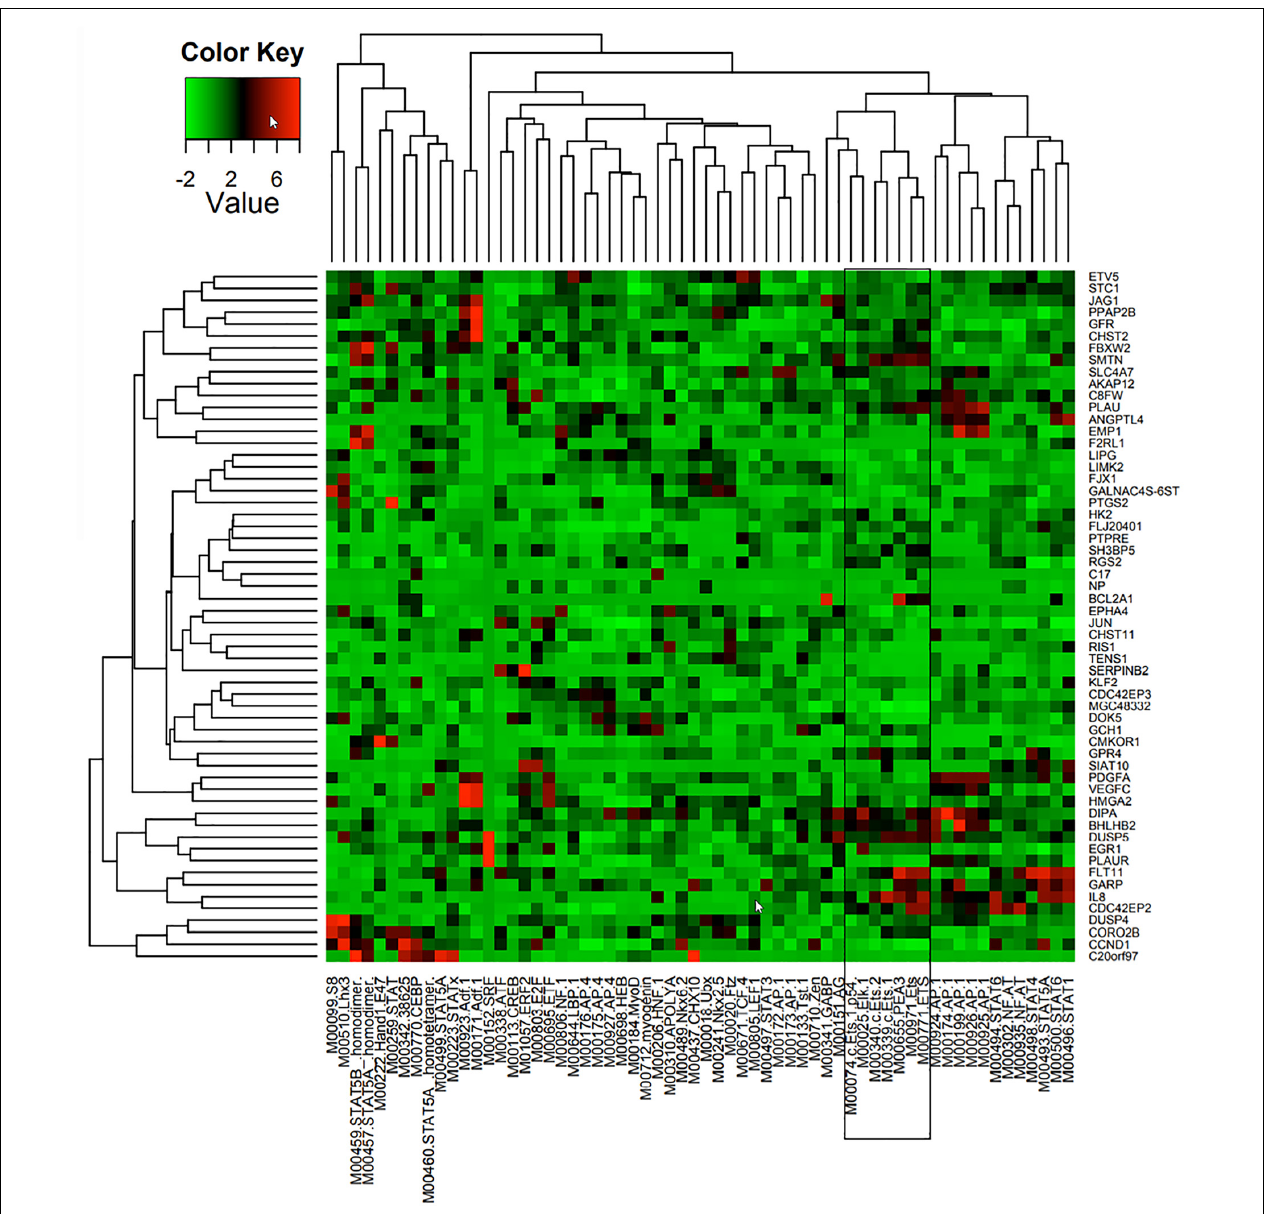
FIGURE 1 | Predicted TF regulators of Ang-1-induced genes in ECs. Heat map representing 58 genes ( Y axis) that were upregulated in HUVECs in response to 4 h of Ang-1 exposure. Genes are clustered according to Z-scores obtained from 62 position weight matrices generated using TRANSFAC and JASPAR databases and based on flanking regions 10 kb upstream or downstream of each gene ( X axis). Color scale represents value of